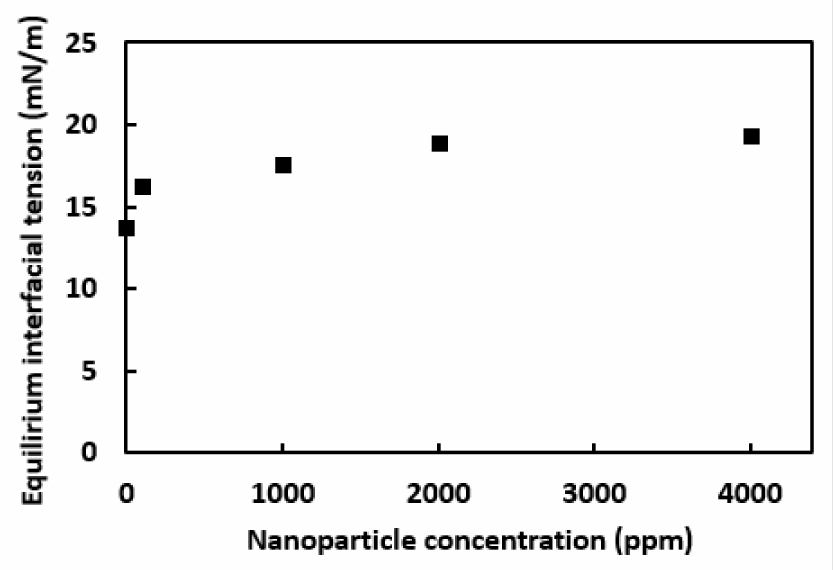
Figure 7. Equilibrium crude oil-water interfacial tensions in the presence of Span 80 at different nanoparticle